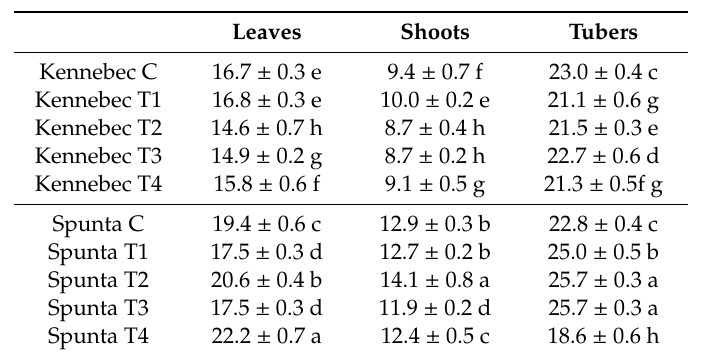
Table 2. Dry matter (%) of leaves, shoots and tubers of the studied potato varieties in relation to the fertilization